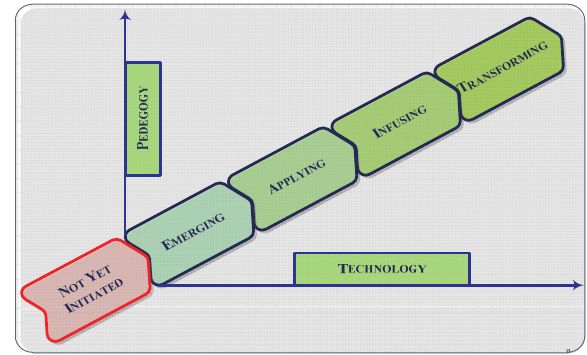
Figure 1: Stages in adoption and use of ICT